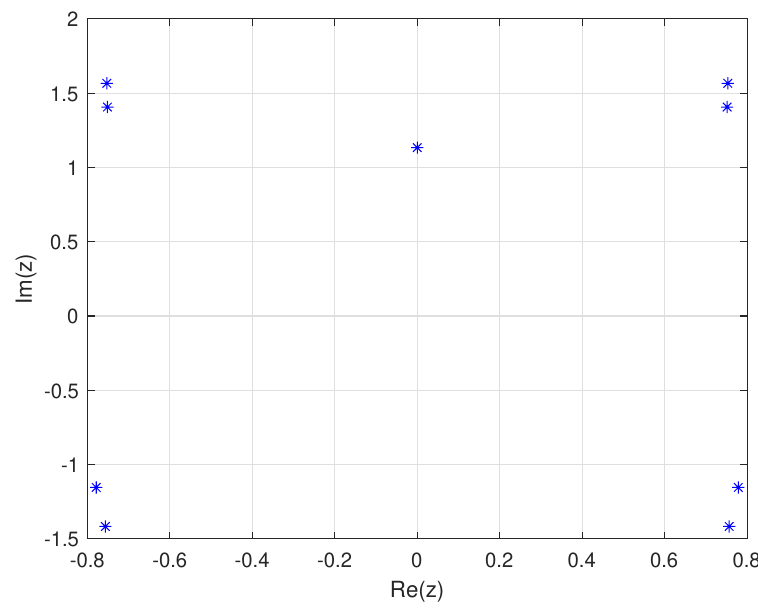
Figure 5 . A distribution of zero roots { z l } for the ground state and the low-lying excited state for N = 10 and η = 0 . 75 + iπ